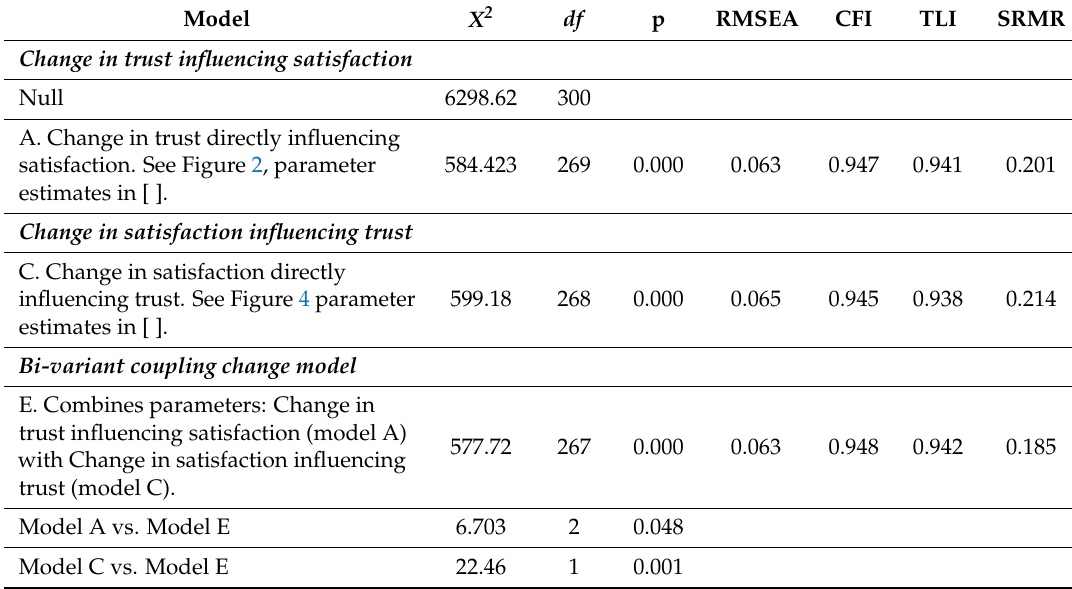
Table 4. Examining the relationship between changes in cognitive trust and changes in satisfaction with one’s